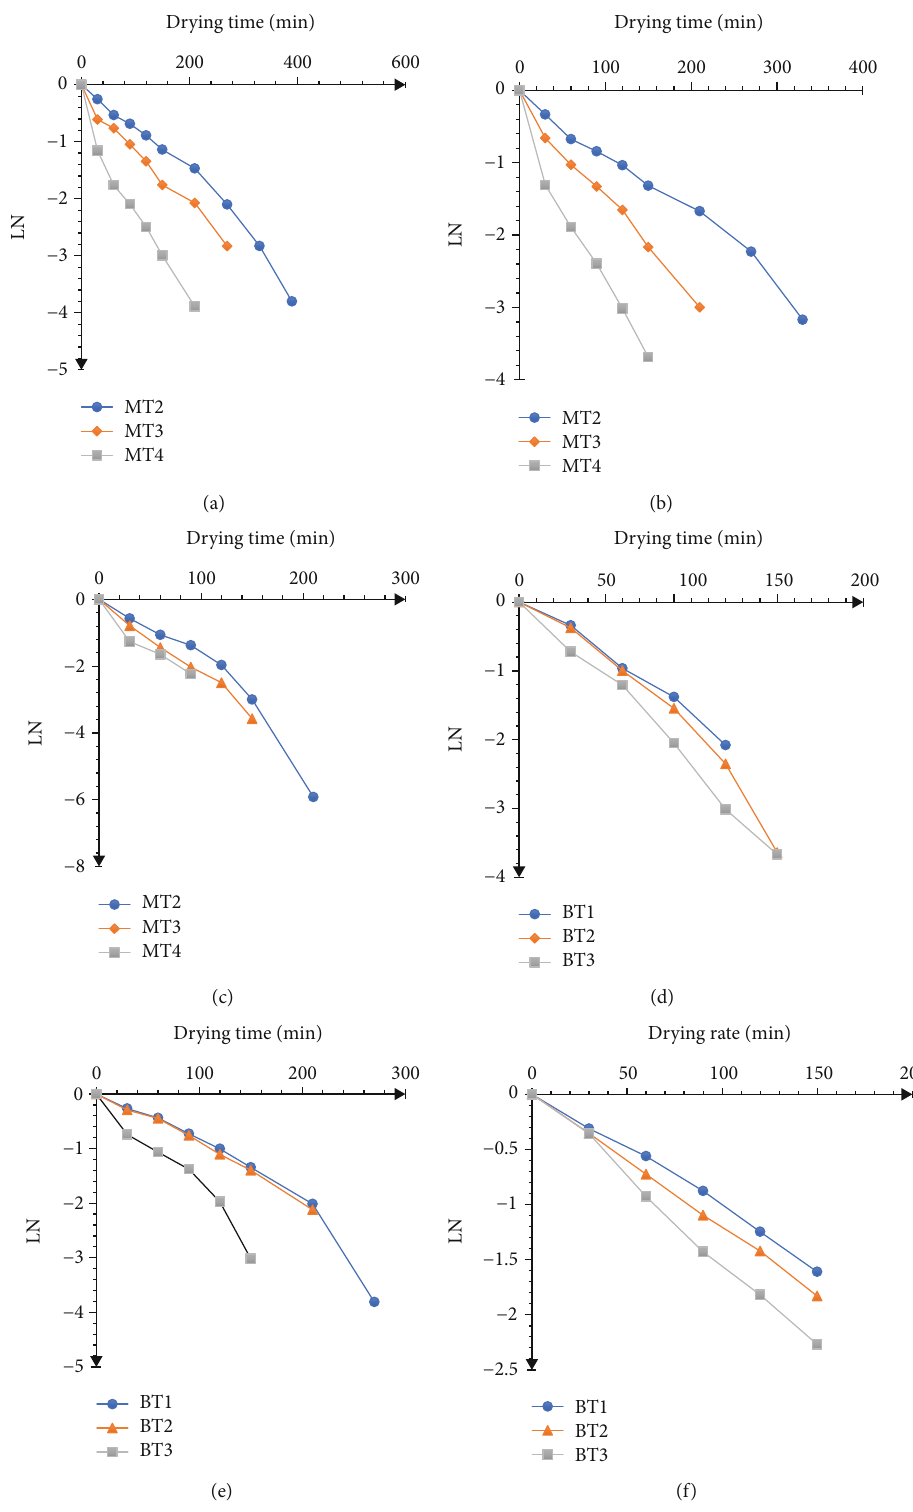
Figure 2: Variation of ln ð MR Þ against drying time plots for Variation of ln ð MR Þ against drying time plots for microwave-assisted hot air drying at (a) 385 W, (b) 541W, and (c) 697W blanched-assisted drying samples with thickness (d) 3 mm, (e) 6 mm, and (f) 9 mm at 70 ° C. MT2, MT3, and MT4 are 2 min, 3min, and 4min microwave treatments. BT1, BT2, and BT3 are 1min, 2 min, and 3 min blanching treatments,